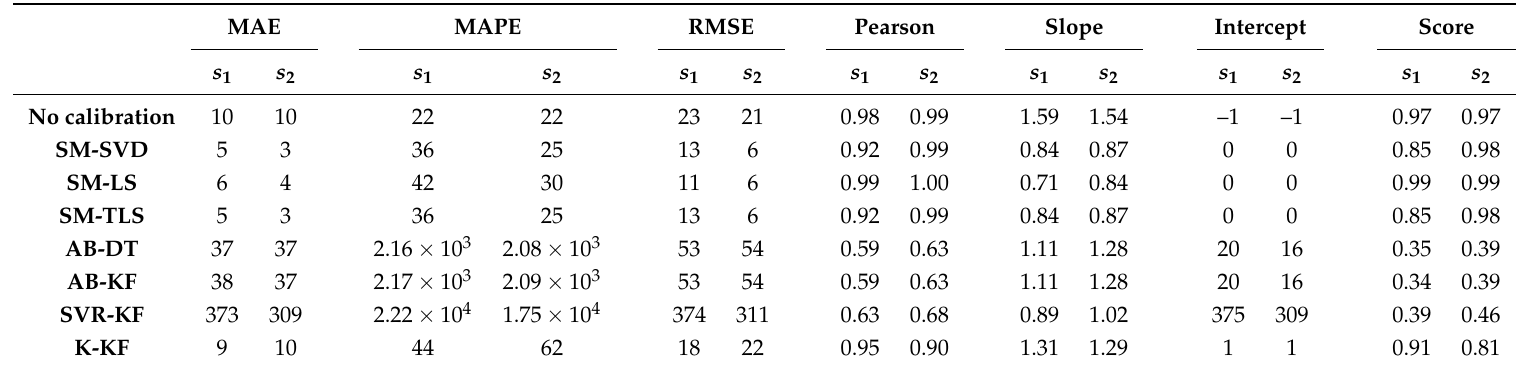
Table 10. Values of the metrics, computed on the entire time interval of study, for two particular sensors of the network s 1 = 2 and s 2 = 10, with the Gaussian plume model. For these instruments, the results are quite equivalent to those of Table 8 in orders of magnitude MAE MAPE RMSE Pearson Slope Intercept Score s